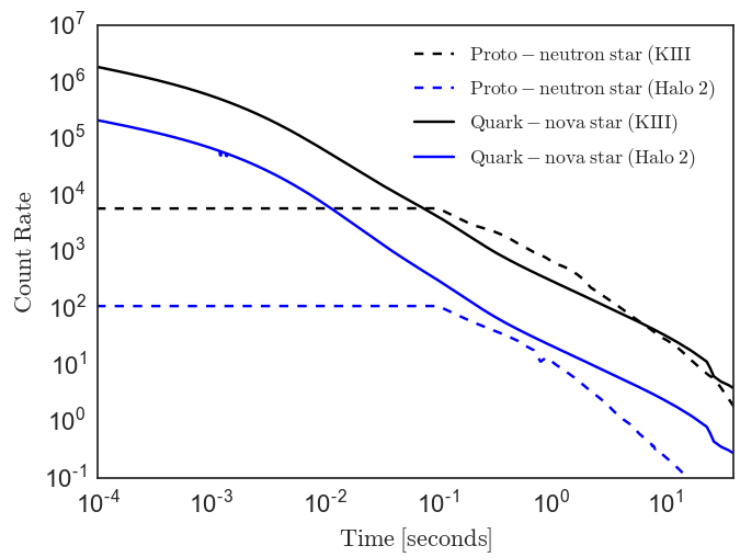
Figure 3. Detector count rates for a quark-nova vs. proto-neutron star for Super-Kamiokande III and Halo 2. Reprinted from Ref.